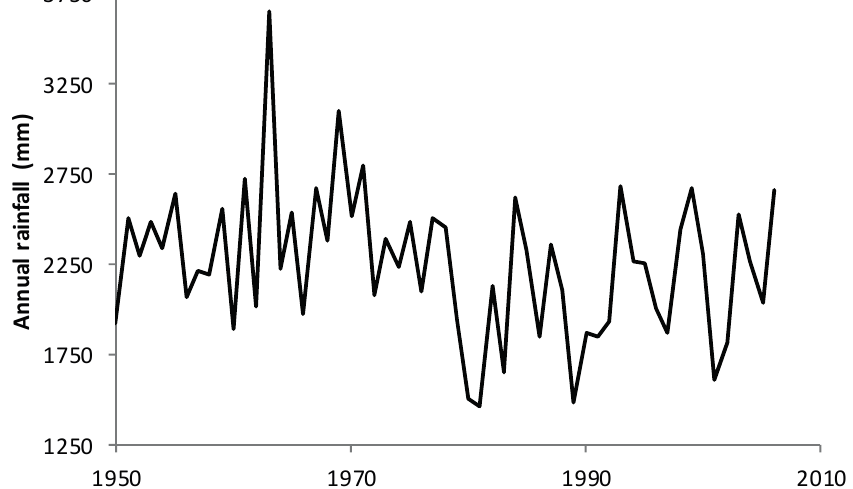
Figure 4. Annual rainfall totals at Mapalana